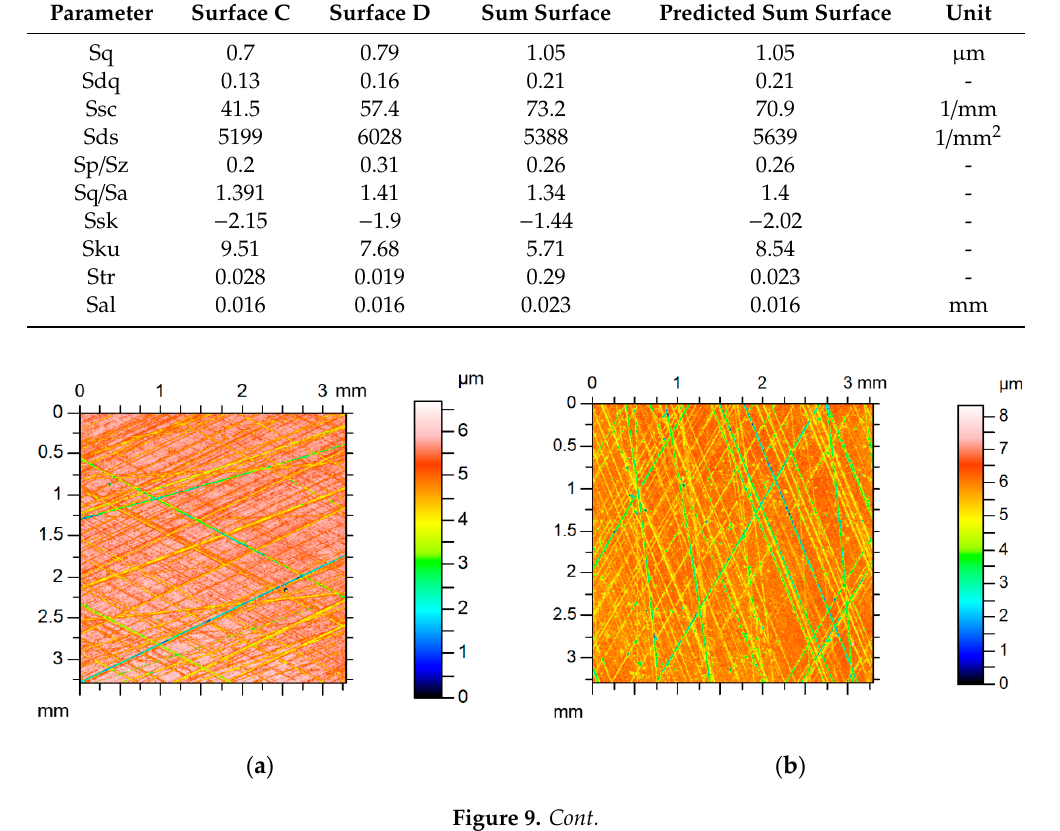
Table 4. Selected parameters of surface C, of surface D, of the sum surface, and of predicted parameters of the sum surface.